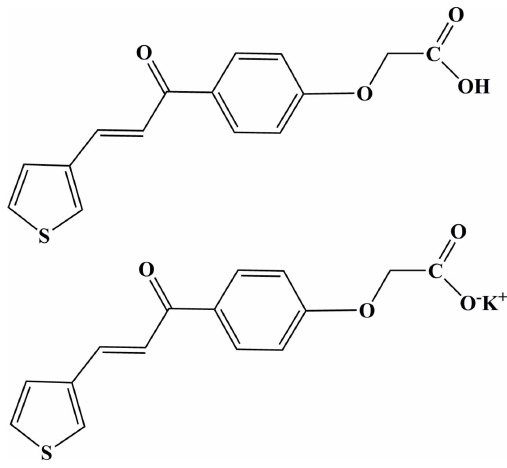
Table 1 Hydrogen-bond geometry (A˚ , (cid:2) ).